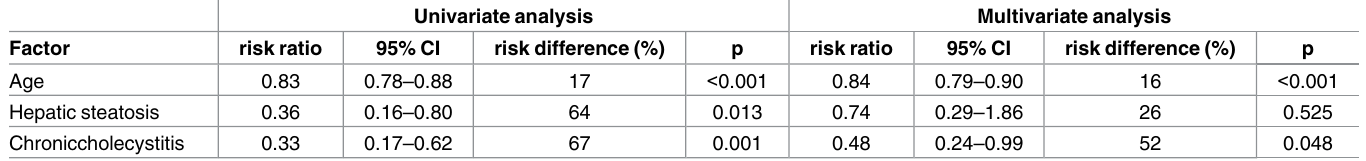
Table 2. Associated factors of diarrhea after living liver donor hepatectomy in living liver transplant